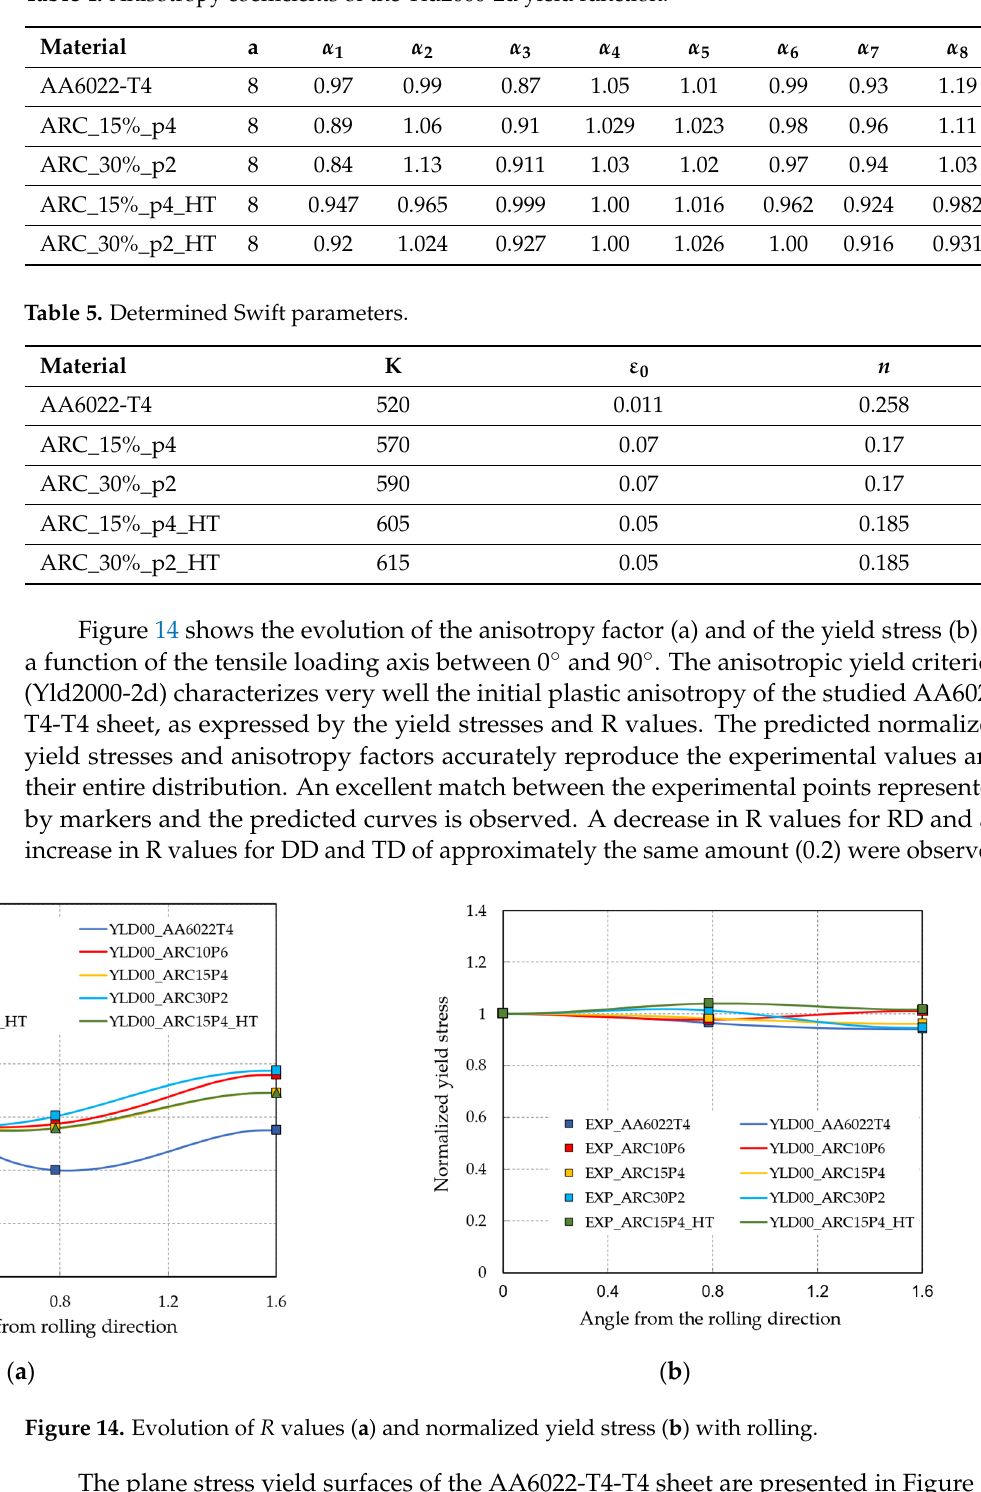
Table 4. Anisotropy coefficients of the Yld2000-2d yield function.